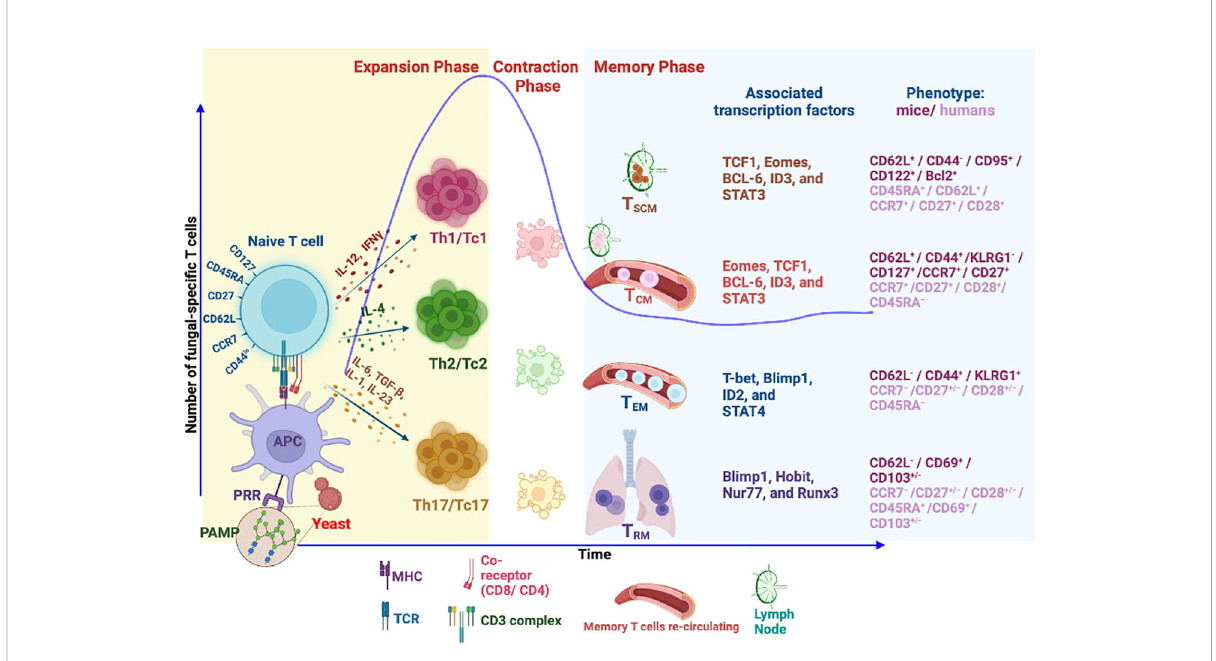
FIGURE 1 Differentiation and generation of memory T-cell subsets. Following recognition of fungal PAMPs by PRRs, activated antigen-presenting cells (APCs) process the antigen from phagocytosed fungus to load onto MHC molecule. MHC – peptide complex is recognized by cognate TCR of naïve T cells leading to TCR signaling, activation, and differentiation of T cells into different subsets directed by different cytokine milieus. The differentiated T cells accompanied by proliferation during expansion phase secrete in fl ammatory cytokines to aid in fungal killing. Fungal clearance usually coincides with initiation of T-cell contraction phase where 90% of effector cells die by apoptosis. The remaining cells differentiate to become long-lived memory cells. Memory T cells express unique phenotypic attributes and transcription factors, some of which dictate homing to lymphoid organs (CCR7/CD62L). Tissue-resident memory T cells (T RM ) continue to reside in tissue of responses. The effector memory T cells (T EM ) continue to invigilate the pathogen by recirculation between peripheral tissues and blood. Self-renewing central memory (T CM ) and central memory stem T cells (T SCM ) are preferentially home to secondary lymphoid organs and serve as “ seeders ” of secondary effector and memory T cells when needed. PAMPs, pathogen-associated molecular patterns; PRR, pattern recognition receptors; Th, helper T cell; Tc, cytotoxic T cell (CD8 + T cell); T SCM , stem memory T cells; T CM , central memory T cell; T EM , effector memory T